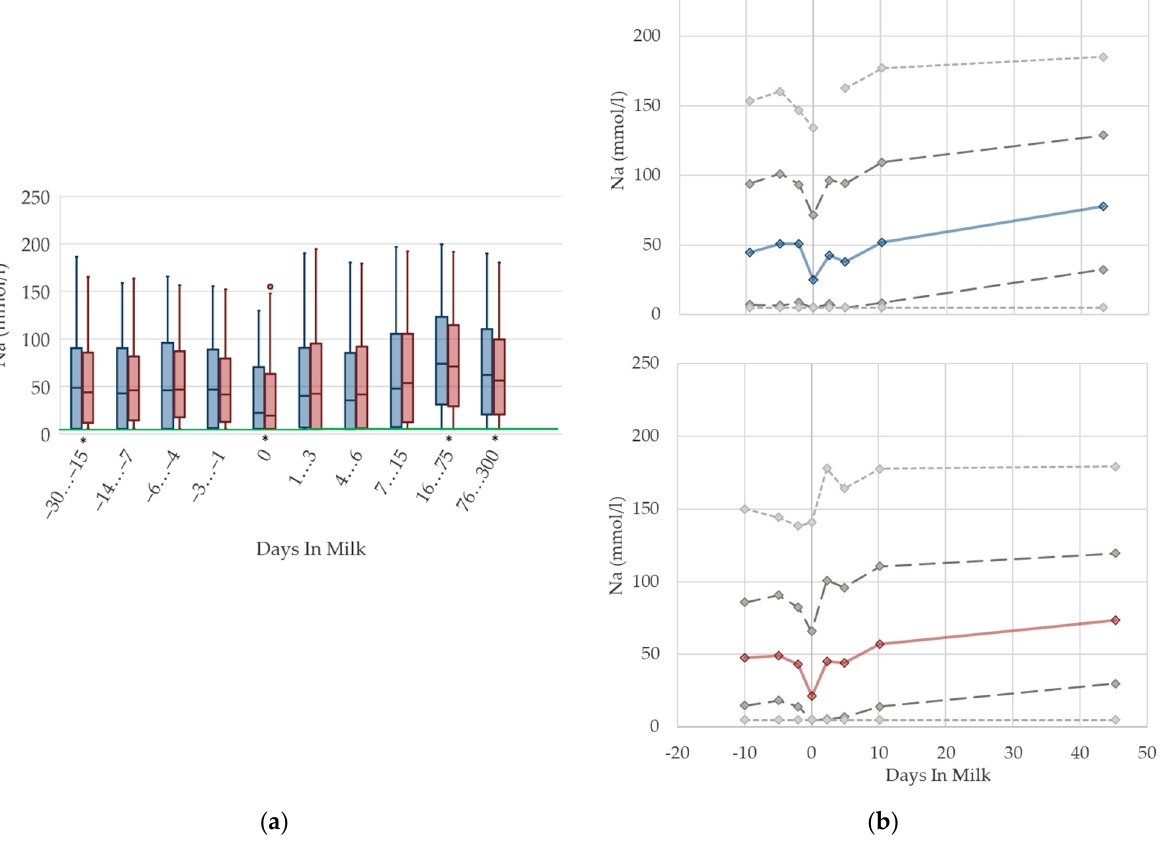
Figure 13. Urine concentrations of sodium (Na) in primiparous (blue) and in multiparous (red) cows ( a ) in 10 classes between 30 days prepartum to 300 days postpartum (boxplots), green continuous lines represent the reference values according to Fürll [23], asterisk indicates significant differences regarding parity within DIM class; and ( b ) in 8 classes from 10 days prepartum to 40 days postpartum (median—continuous line; 1st and 3rd quartile—dashed lines; percentile 5 and 95—dotted lines).